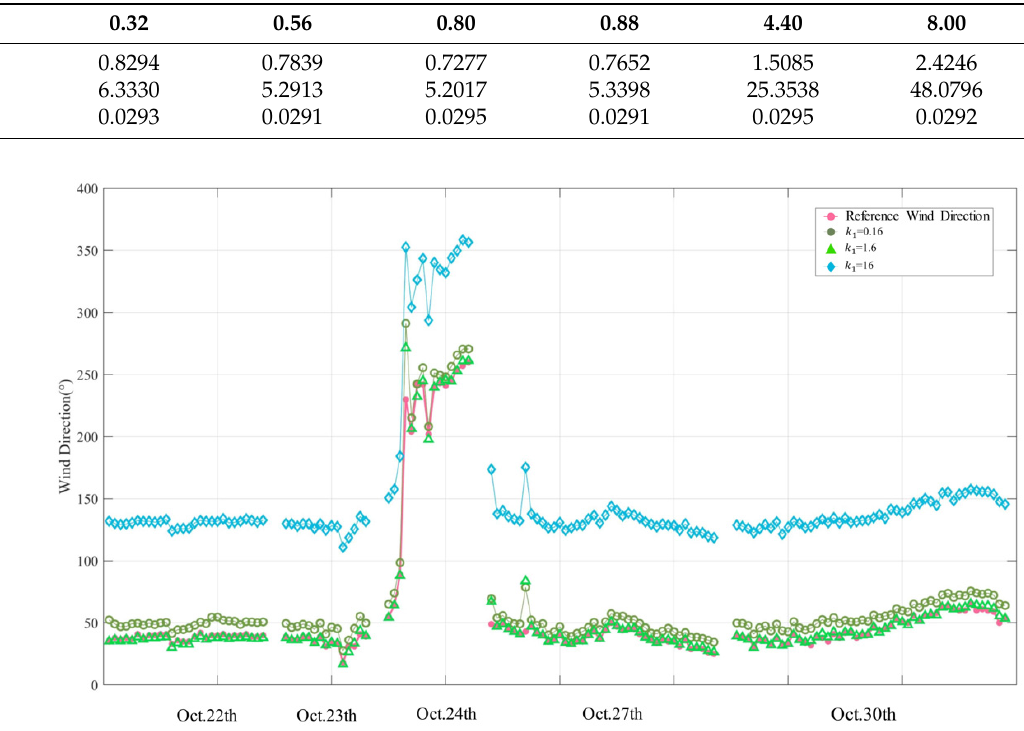
k is di ff er- 1